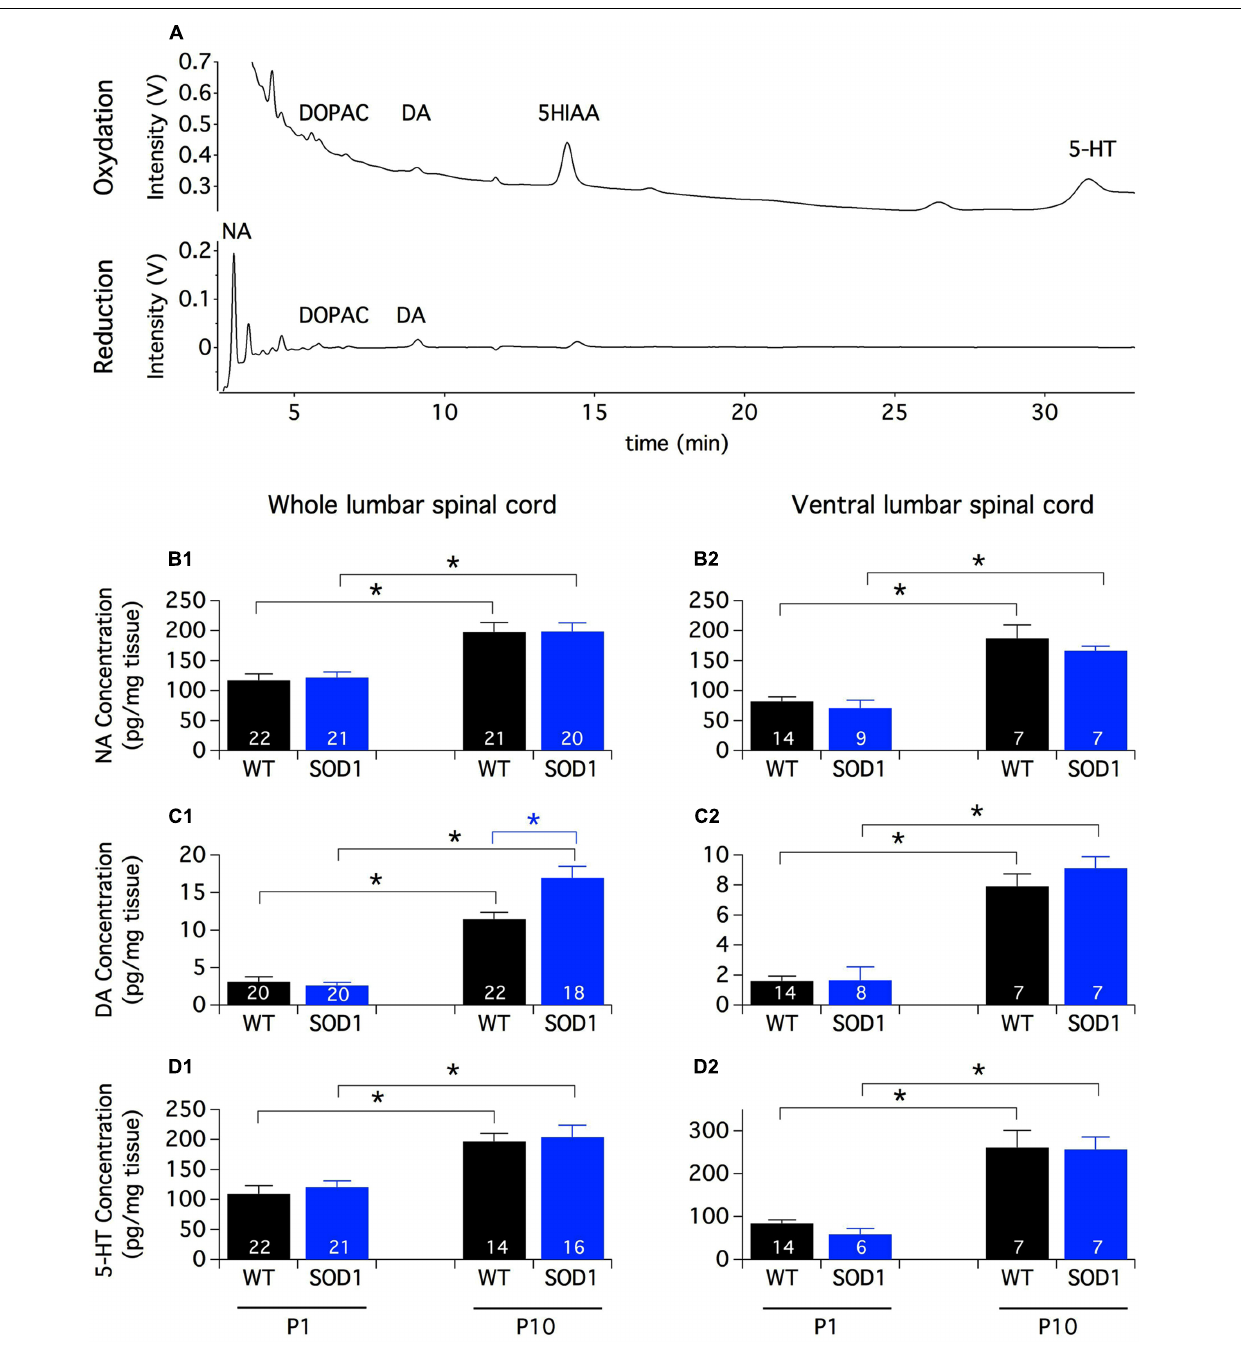
FIGURE 1 | Monoamine contents in the lumbar spinal cord of newborn mice. (A) Example of HPLC chromatograms of a whole spinal cord sample from a P10 SOD1 mouse.The chromatograms represent the output Coulometric signals (nanoampere converted in ± 1V output by the recorder) produced after their separation by the compounds at the level of the electrode of oxidation (upper trace; + 350 mV) and/or the electrode of reduction (lower trace; − 270 mV) of the Coulometric cell. Most of the quantitative analyses are performed using the oxidation channel (all compounds of interest except NA which is often confounded in the solvent front) and NA, DOPAC and DA